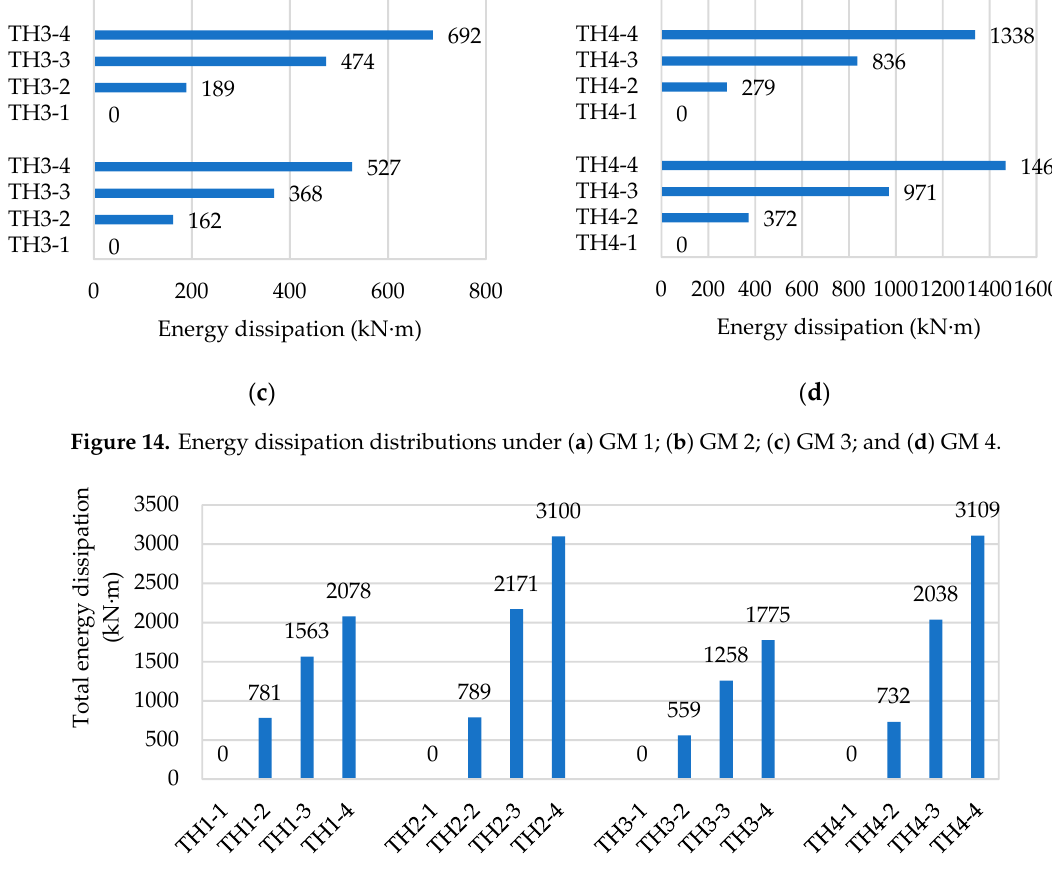
Figure 15. Total cumulative energy dissipation.